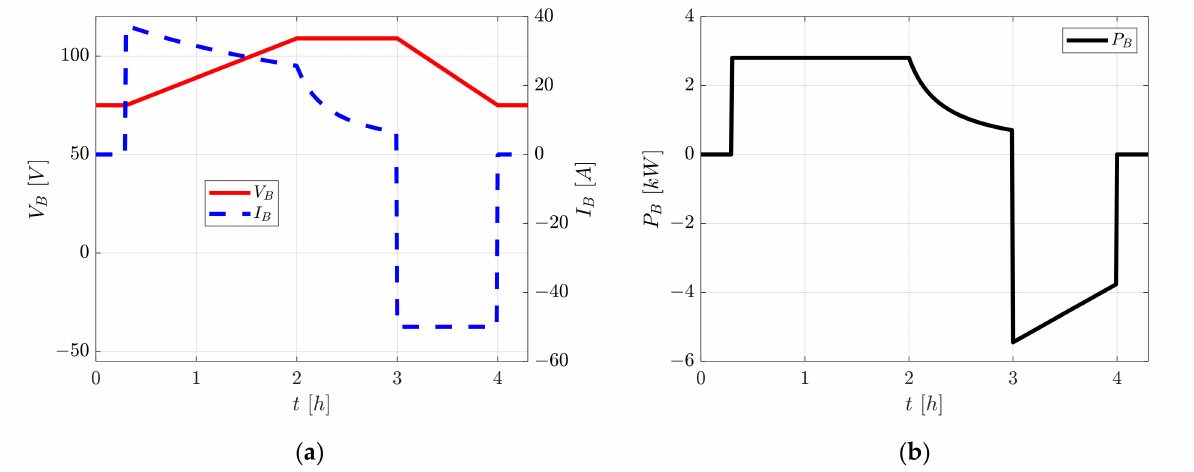
Figure 12. Battery-related quantities during charging (from 0 to 3 h) and discharging mode (from 3 to 4 h): ( a ) voltage and current and ( b )